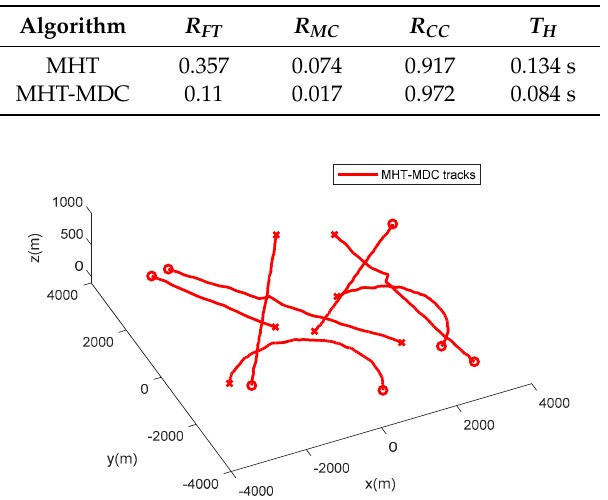
Figure 8. The estimated trajectories of the MHT in scenario 1. Figure 9. The optimal sub-pattern assignment (OSPA) distance of two algorithms in scenario 1.